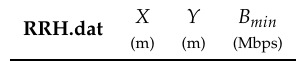
Table 4. Required inputs for the “RRH.dat”